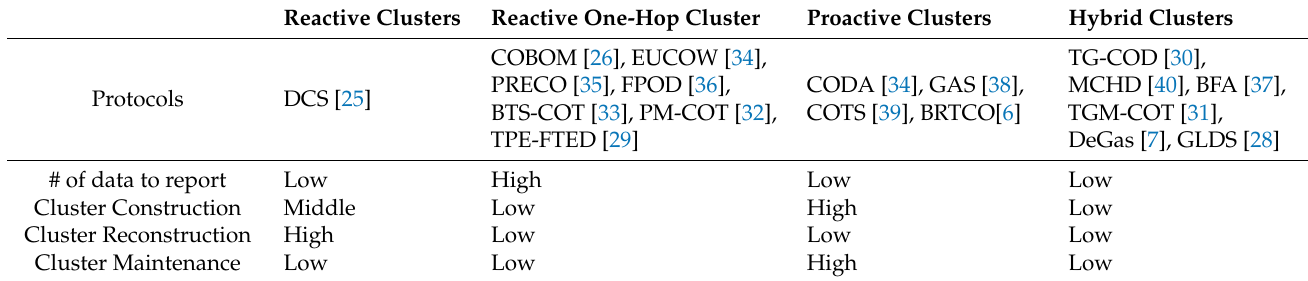
Table 2. Comparison of technologies in terms of clustering